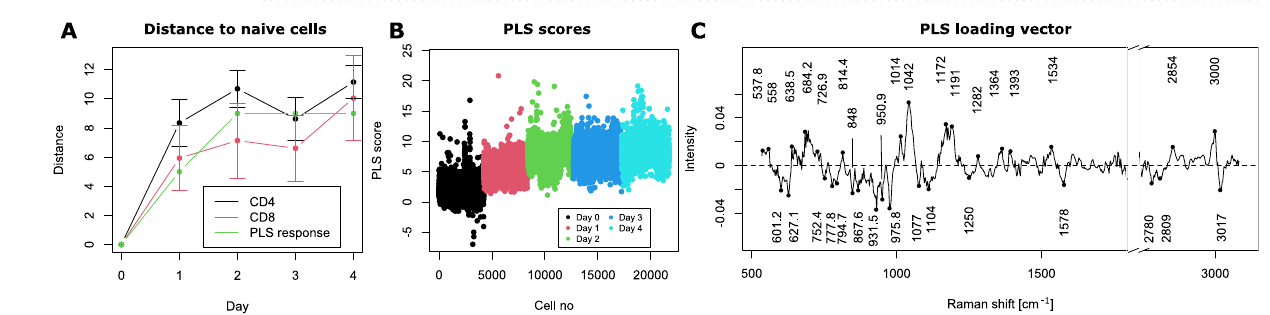
Figure 4. Comparison of cells differentiated in vitro and ex vivo effector cells. ( A ) CD62L/CD44 expression of CD4 + cell populations, with the gates employed for sorting naive and effector cells. ( B ) ROC curves of classification performance between naive and effector cells (N = 4000 for each class for training, test performed on 20% of the data). ( C ) Density plot of naive and effector cells retrieved by fluorescent cell sorting projected on the UMAP derived from cells displayed in Fig. 3A. Original naive CD4 cells retrieved by magnetic sorting (day 0, see Fig. 3A) are also displayed for comparison.